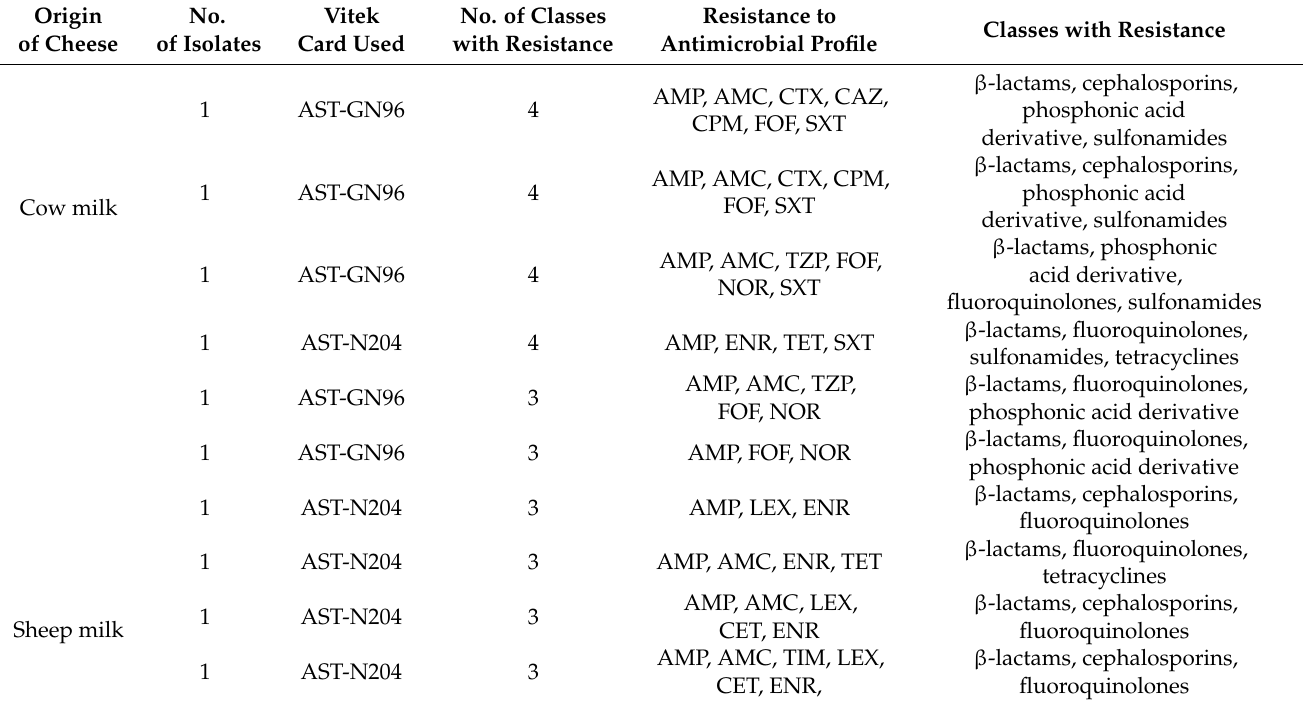
Table 4. Multi-drug resistance phenotype combination of the tested E. coli